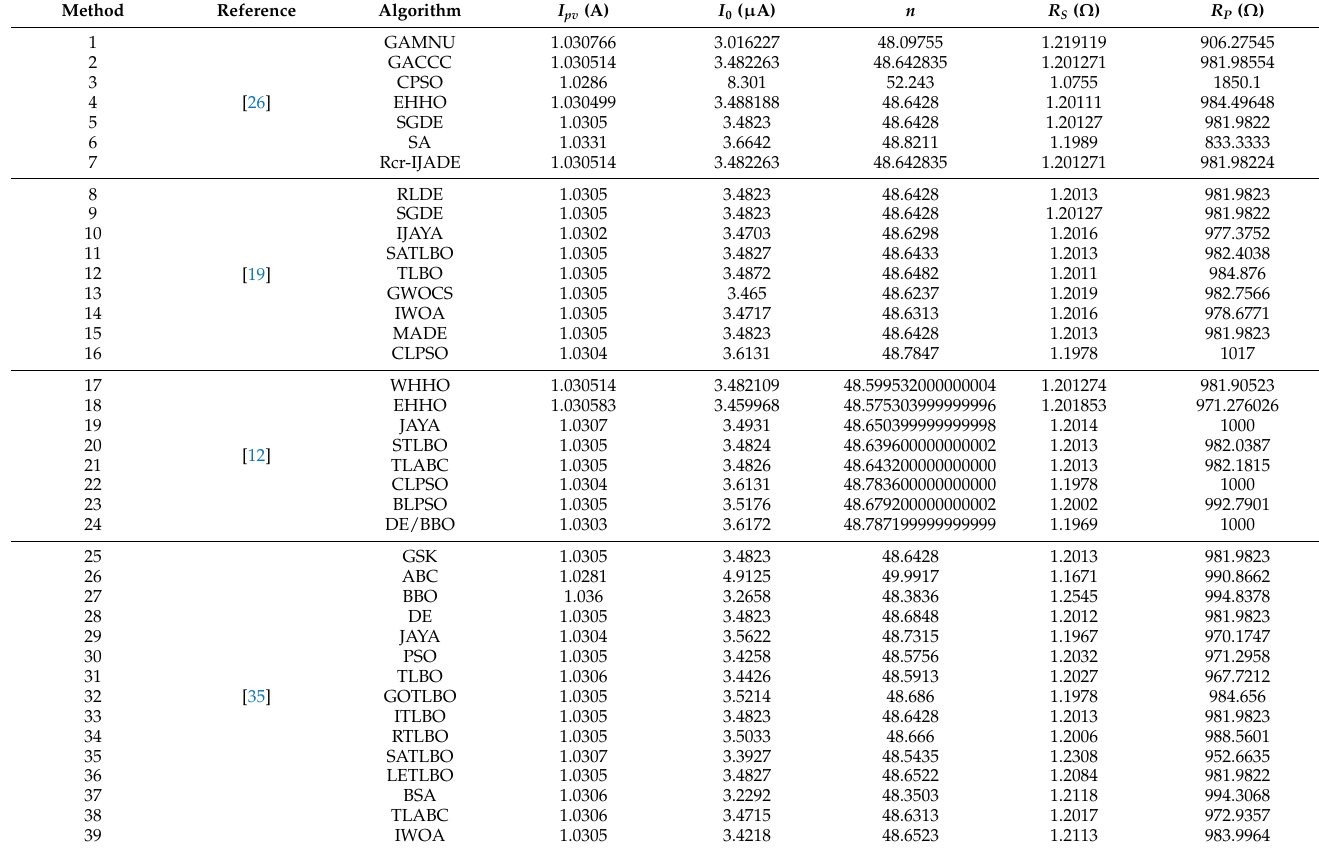
Table A2. Parameters values of the Photowatt-PWP201